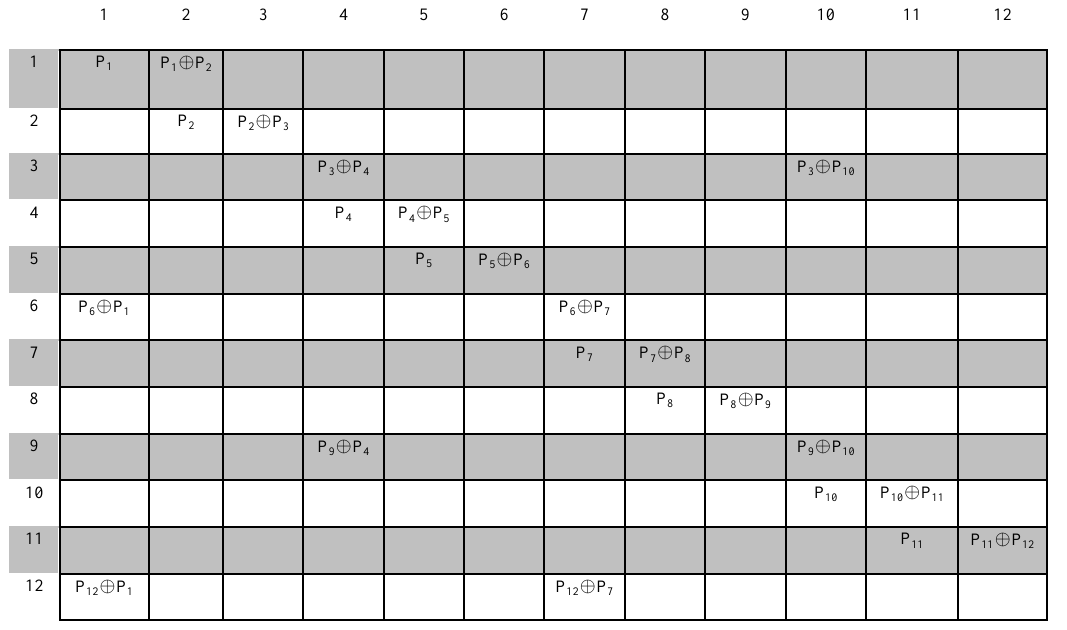
Figure 5. Received matrix at the